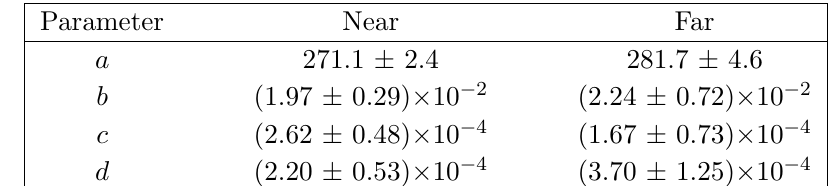
Figure 7 . Comparison of data and simulated energy spectra of the (cid:12) -decay electrons from unstable 12 B and 12 N isotopes produced by cosmic muons. The measured spectra in the near and far detectors are also compared after normalization to the total number of events in the far detector. The far-to- near ratio of the spectra is shown in the lower panel. The good agreement demonstrates identical performance of the near and far detectors and the MC reproducibility in the energy reconstruction.